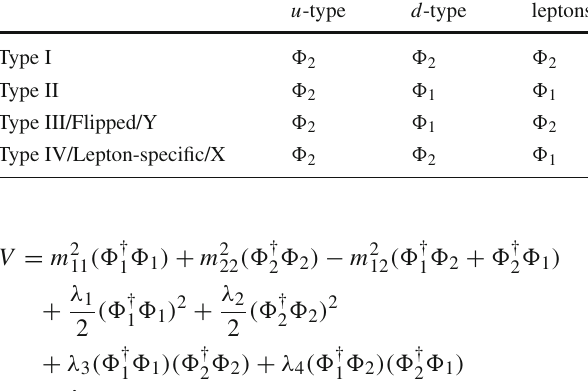
Table 1 Allowed fermion couplings in the four 2HDM types u -type d -type